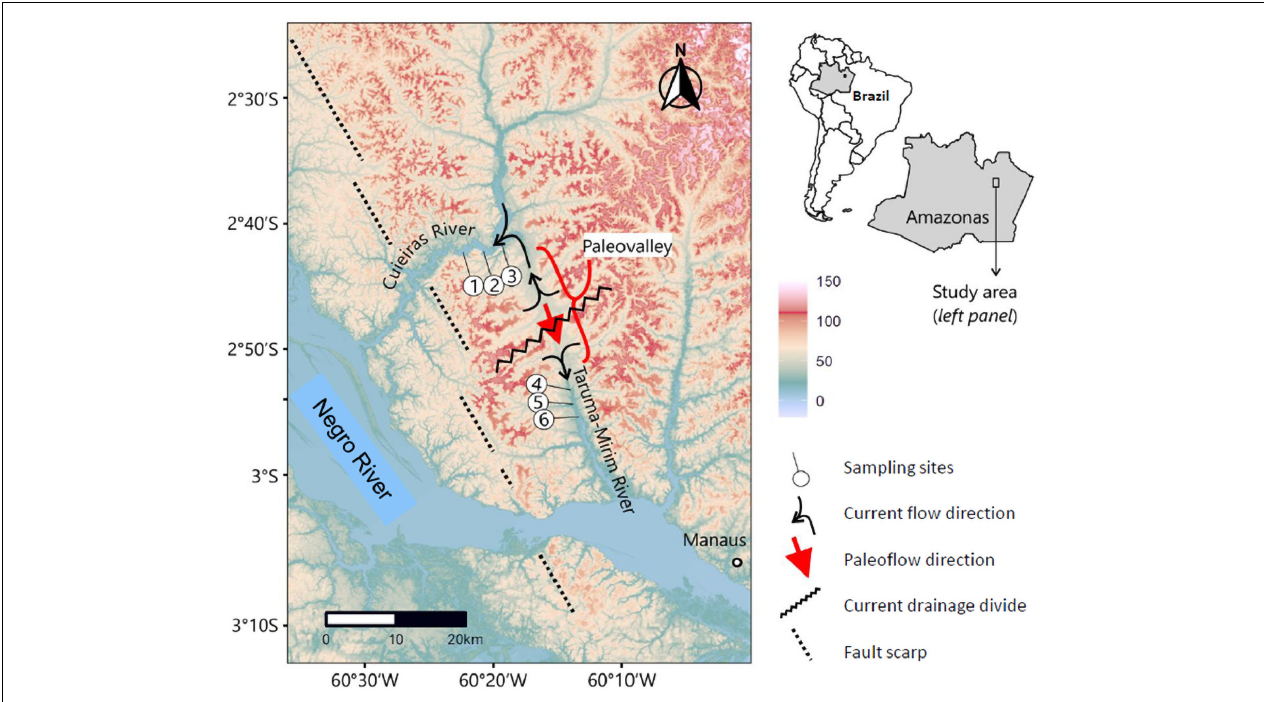
FIGURE 1 | Location and topography of the study site. Color scheme denotes elevations above mean sea level and was obtained from a digital elevation model ( Shuttle Radar Toporaphic Misson —SRTM, http://earthexplorer.usgs.gov). Map produced by Rodrigo Nahum, 2020. Locations of sampling sites, rivers, and other features of the landscape are labeled. Current and past directions of river flow are highlighted by arrows (see key). TABLE 1 | Allelic and genetic diversity within populations of Apistogramma gephyra and Apistogramma pertensis from the Cuieira River (CR) and the Tarumã-Mirim River (TMR), based on microsatellite data. Allelic diversity Genetic